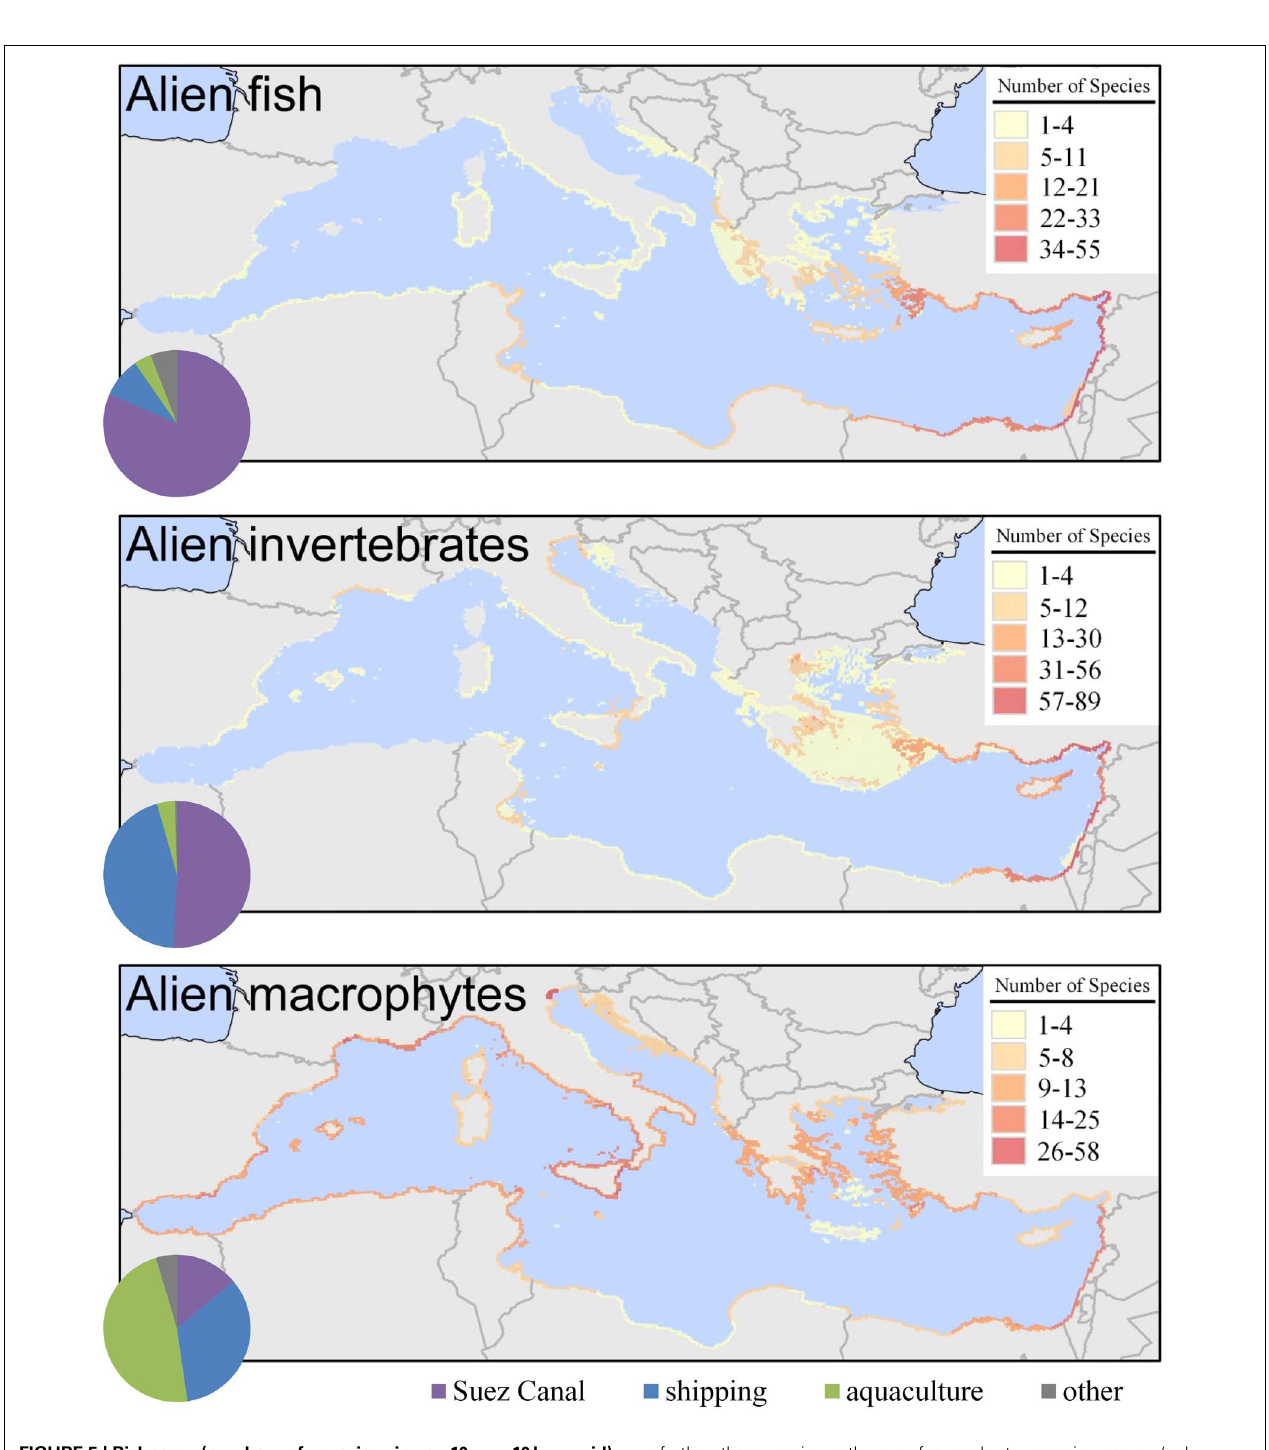
FIGURE 5 | Richness (number of species in a 10 × 10km grid) of alien fish, invertebrates, and macrophytes in the Mediterranean Sea. The pie charts depict the relative importance